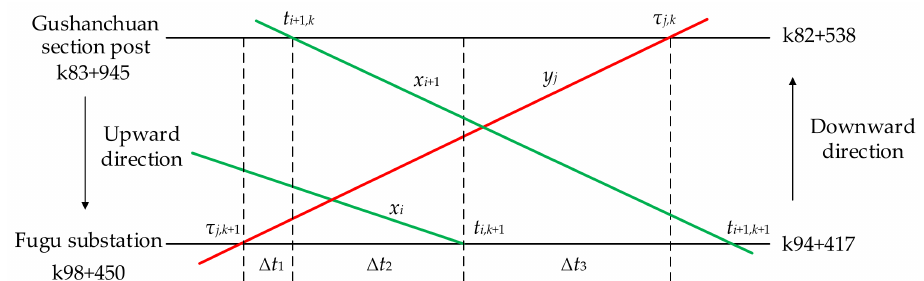
Figure 11. Section train operation diagram from 12:48:27 to